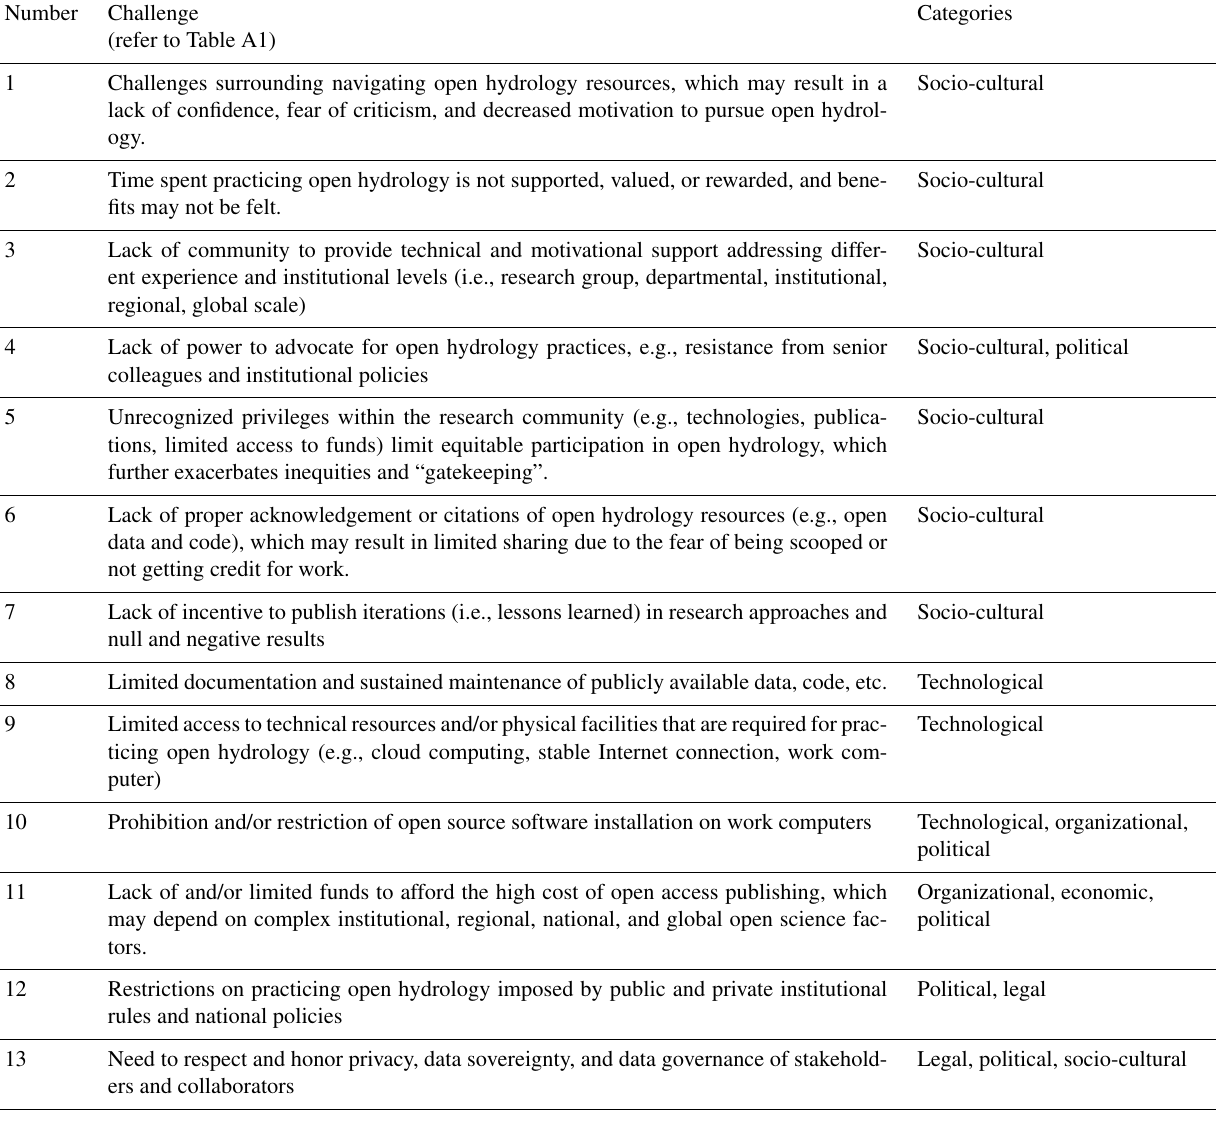
Table A1. List of common challenges that open hydrologists may experience.